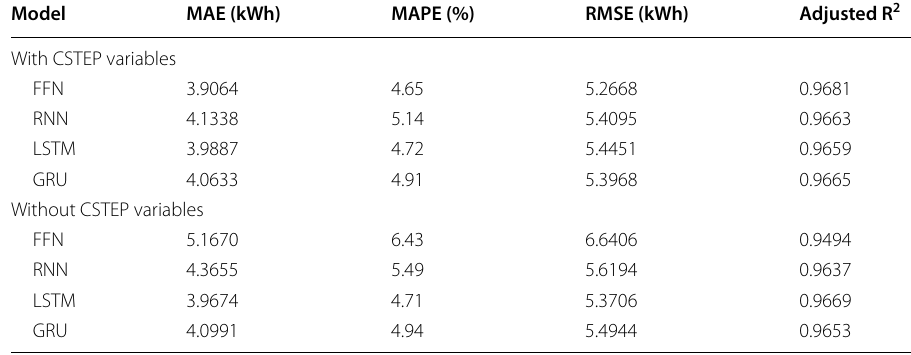
Table 6 One-hour forecast metrics